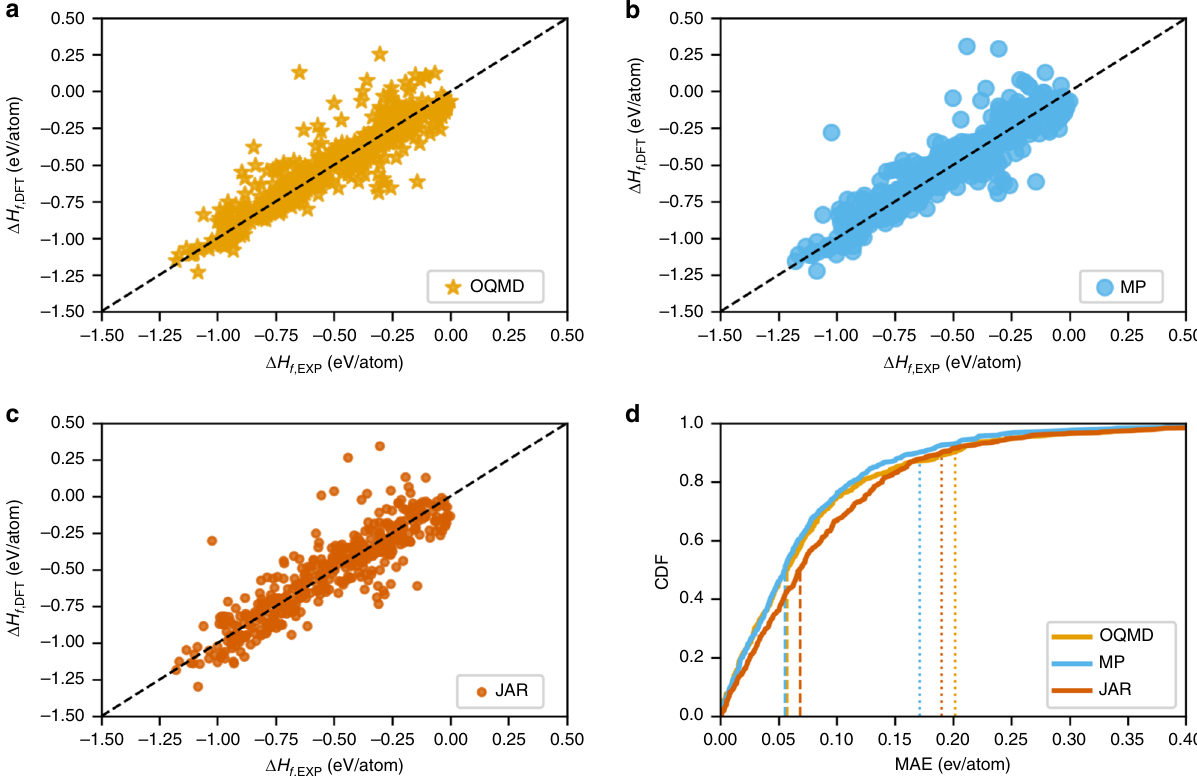
Fig. 1 DFT-computed formation energies against the experimental observations. A comparison using scatter plots of the DFT-computed formation energies of 463 materials from a OQMD, b Materials Project (MP), and c JARVIS (JAR) data sets against their corresponding experimental formation energies from Matminer 52 . d CDF of the corresponding DFT-computation errors for the three data